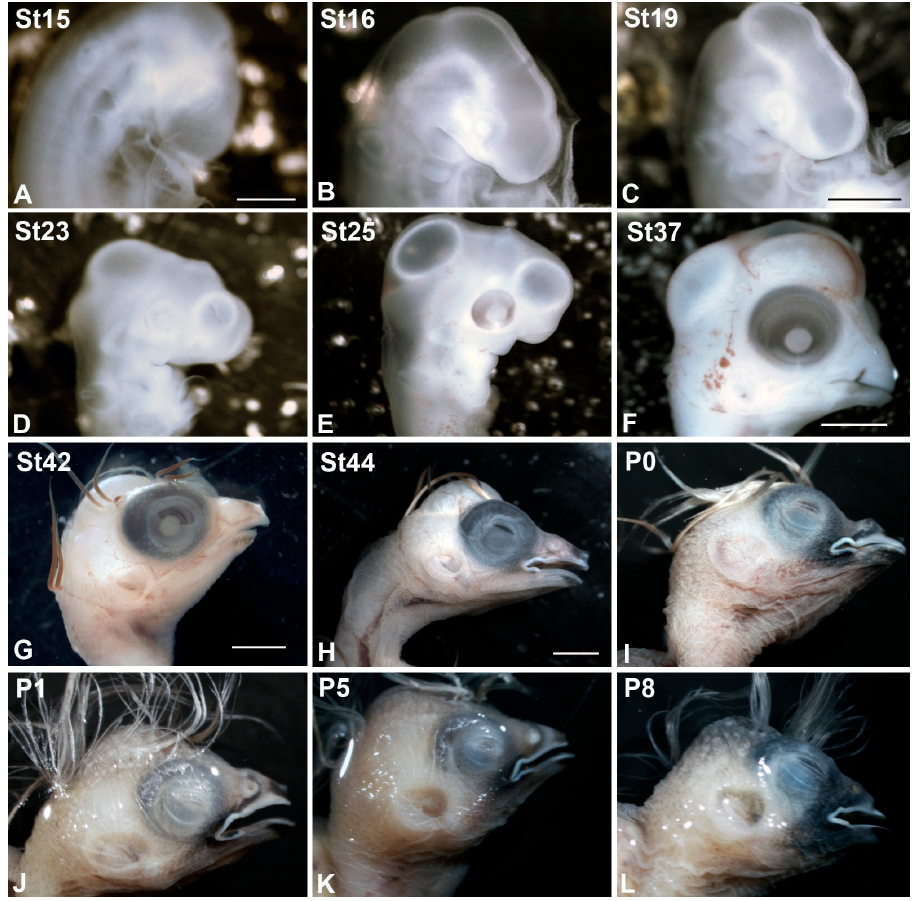
Figure 1. Stereomicroscope images of some embryos and postnatal specimens of Taeniopygia guttata showing the external morphological changes of the eye. The embryos were staged in accordance with the developmental stages (St) established by [51]. Murray et al. 55 (2013). The optic cup was distinguishable between St15 and St23 ( A – D ). Pigmentation in the RPE was observed at St25 ( E ). At St37, the eye was completely pigmented ( F ). From St42 until perinatal stages, the eyelids pro- gressively covered the eye ( G - J ). Eyelids were closed at P5 ( K ), but slightly open at P8 ( L ). Scale bars: 2 mm ( A , B ); 3 mm ( C – E ); 6 mm ( F ); 7 mm ( G ); 10 mm ( H – L